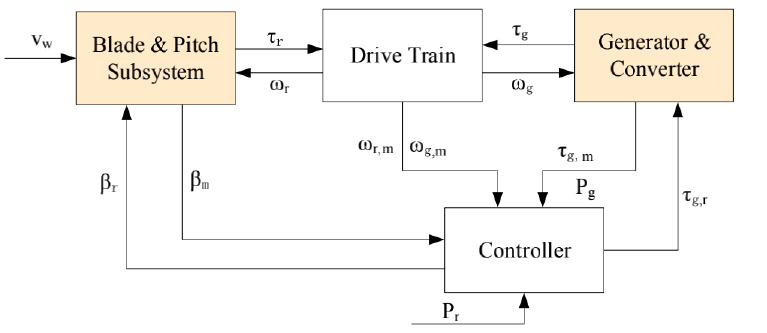
Figure 1. The wind turbine benchmark